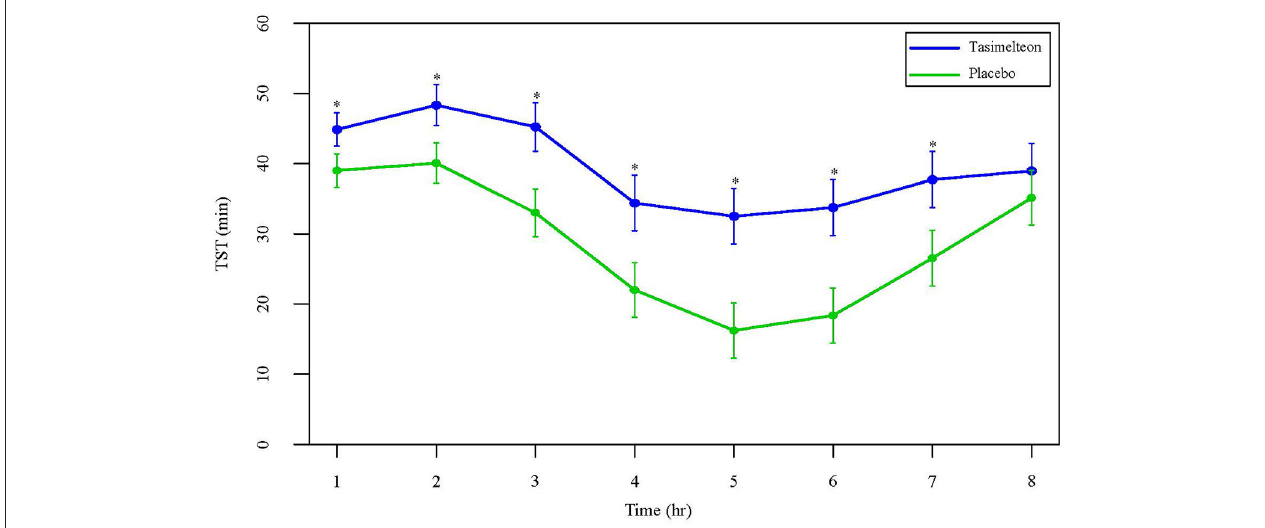
FIGURE 4 | Data are LS Mean (95% CI) for average TST by hour between tasimelteon and placebo. TST during the 8-h phase advance demonstrated a statistically significant increase in the tasimelteon group compared to placebo for hours 1–7. * P <